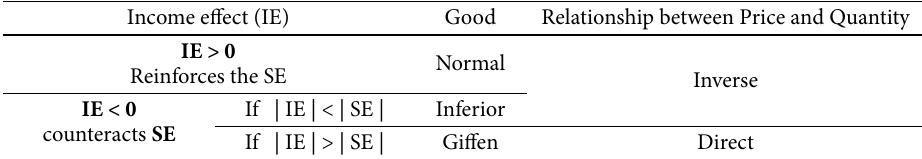
Table 2. Income and Substitution Effects (IE and SE) Income effect